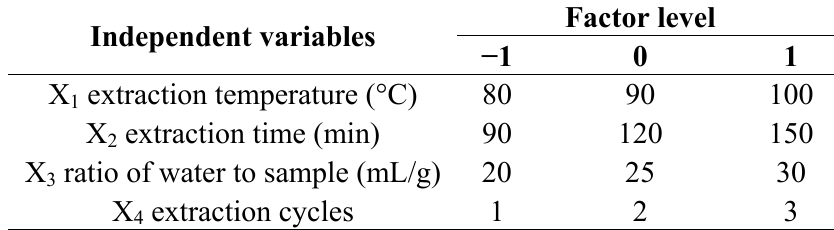
Table 6. Independent variables and their levels used in the response surface